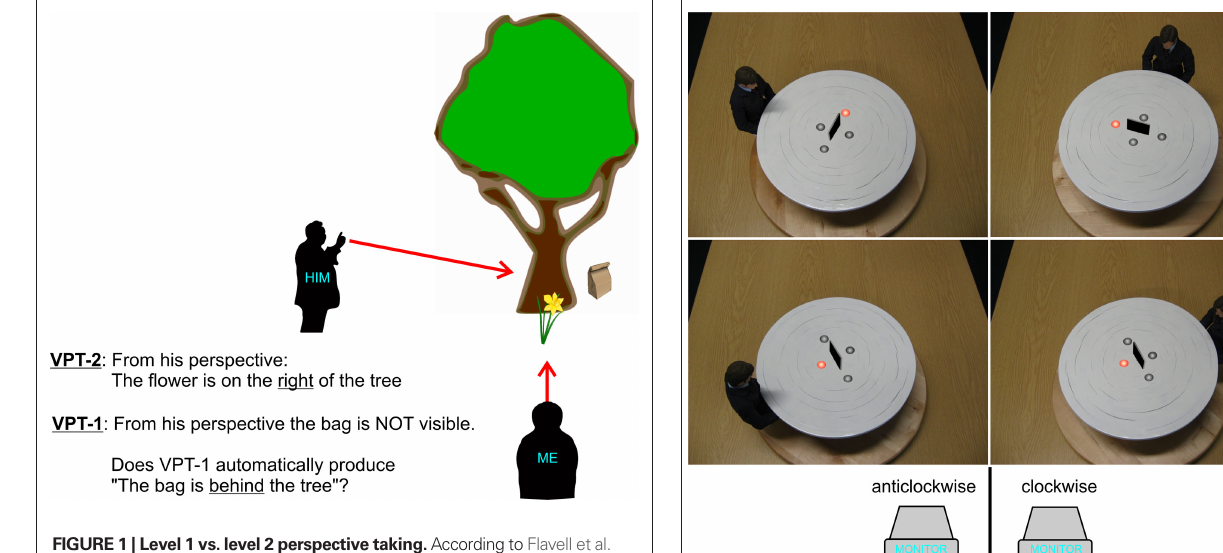
Q2 Figure 2 | Stimuli (top four images) and posture manipulations (drawings at the bottom). The top two images show examples for VPT-2, i.e., the target (red) is left (left image) and right (right image), respectively, from the avatar’s perspective. The two images below show two examples for VPT-1: the target is either visible (left image) or occluded (right image) to the avatar. These stimuli were used in both Experiments. In Experiment 1, participants pressed a key to indicate whether the target was visible/occluded (VPT-1) or left/right (VPT-2). The same stimuli were used in Experiment 2 where participants responded verbally whether the target was “in front”/“behind” or “left”/”right” of the occlusion from the avatar’s perspective. Conform to Kessler and Thomson (2010) we employed several angular disparities (60, 110, 160, 200, 250, 300) and a manipulation of the participant’s body posture (congruent vs. incongruent to the direction of the avatar’s location) as shown at the bottom. Further explanations in the